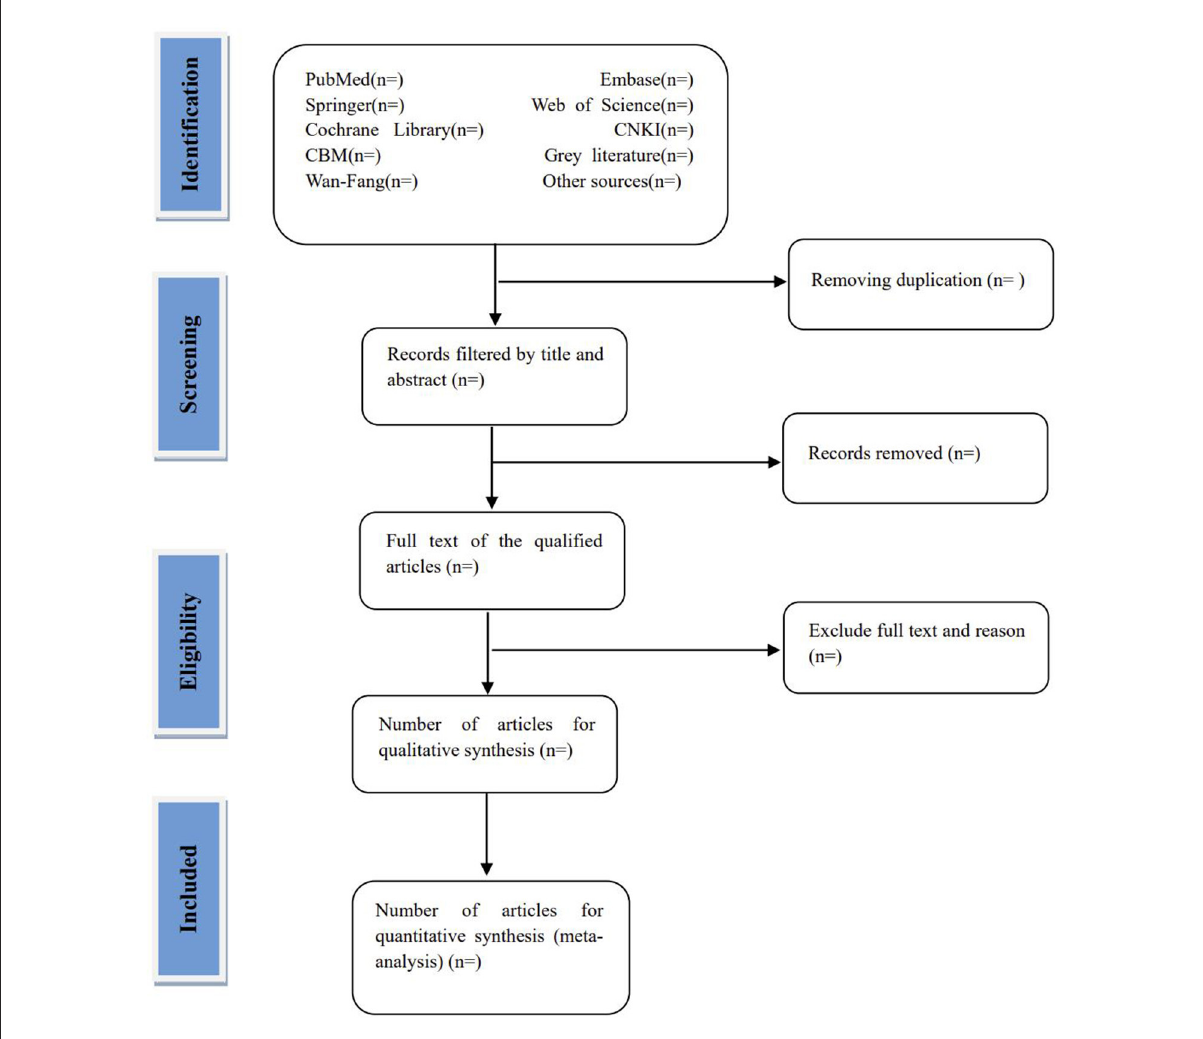
FIGURE1 Flow diagram of studies